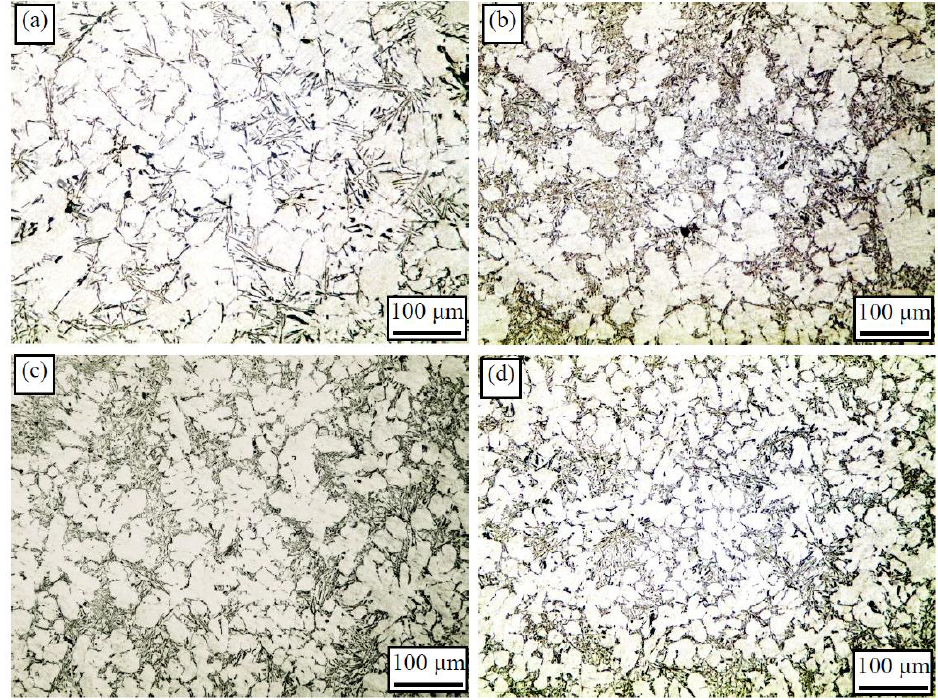
Figure 10. Optical micrographs of as-cast HPRSC A1 alloy treated by UV-ES compound field: ( a ) 0 MPa; ( b ) 100 MPa; ( c ) 200 MPa; ( d ) 400 MPa.